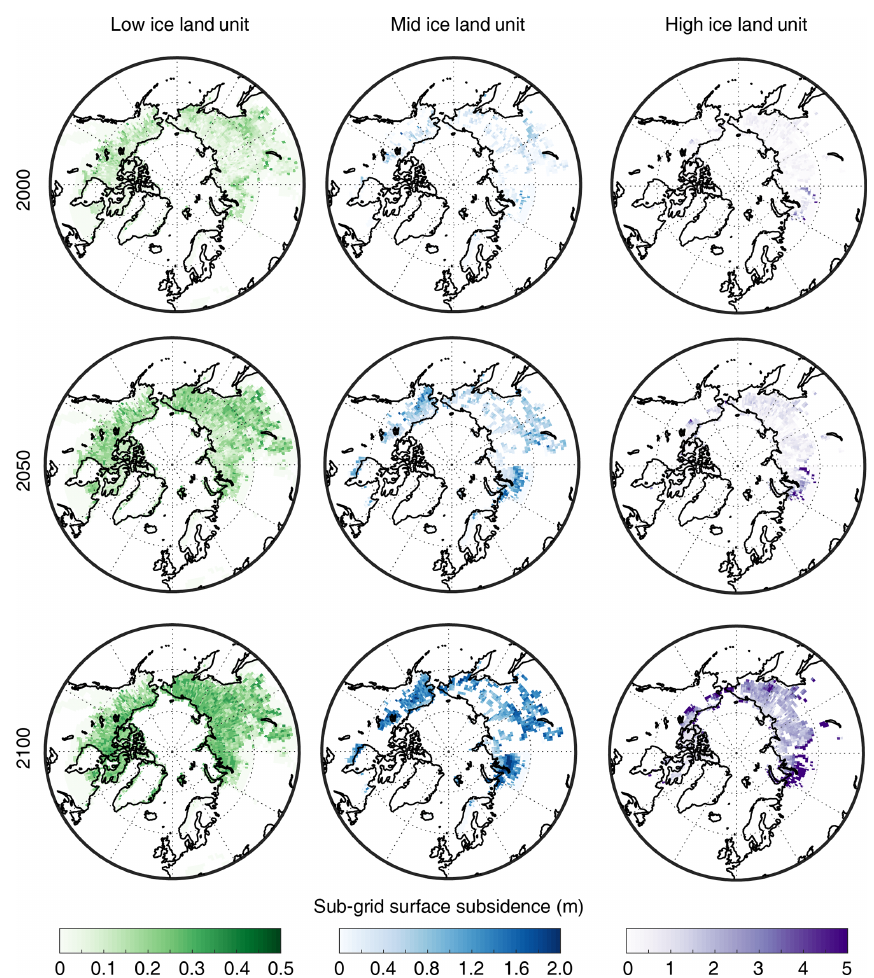
Figure 6. Maps showing sub-grid surface subsidence (m) in 2000, 2050, and 2100 in the low-, middle-, and high-excess-ice land units in the sub-grid ice